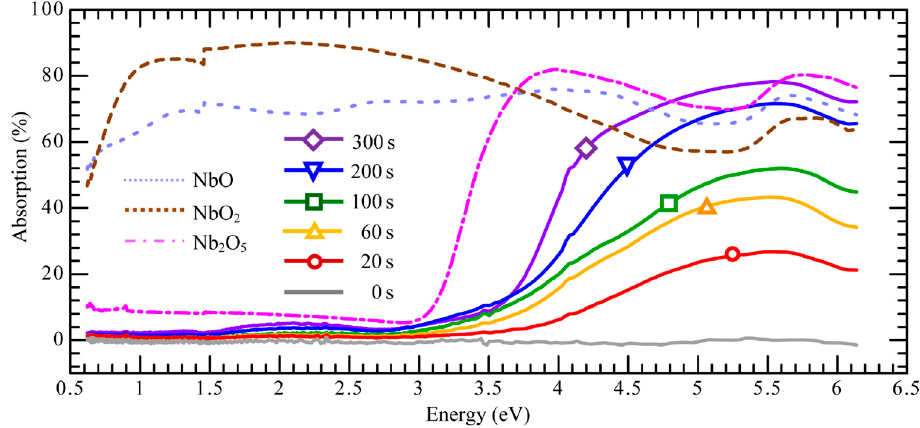
Figure 5. Absorption spectra of the NbO x deposits on a quartz glass substrate attained by dual beam transmission measurement and reagent powders of NbO, NbO 2 and Nb 2 O 5 evaluated with an integrating sphere [89].